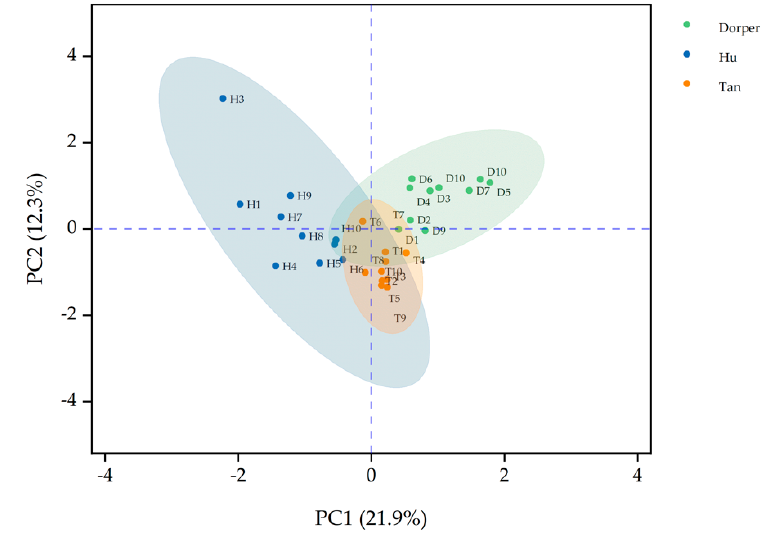
Figure 1. Principal component plot of volatile compounds of lamb meat. PC1: principal component 1 (21.9%), PC2: principal component 2 (12.3%)